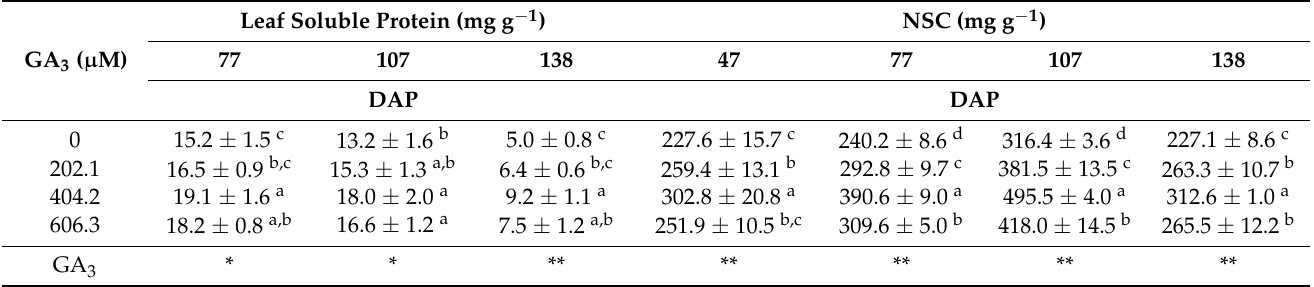
Table 3. The effects of GA 3 level on the leaf soluble protein content and NSC of sesbania pea at different growing dates grown in saline soils.